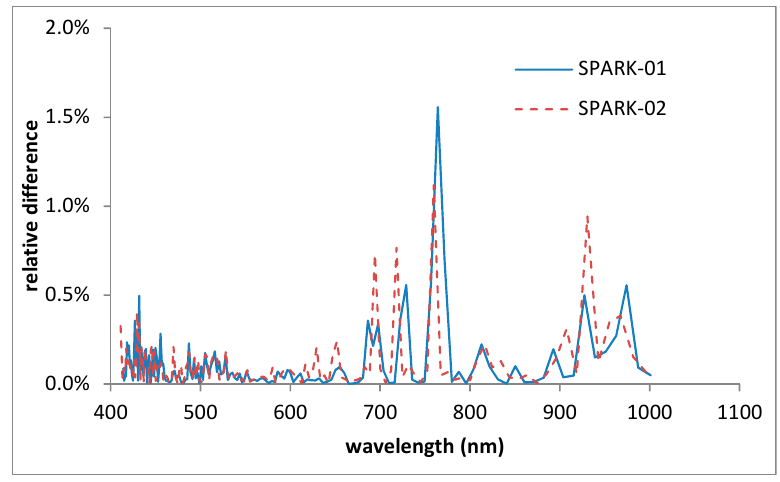
Figure 30. Calibration uncertainties caused by spectral shift of − 0.1 nm for SPARK-01 and -02.